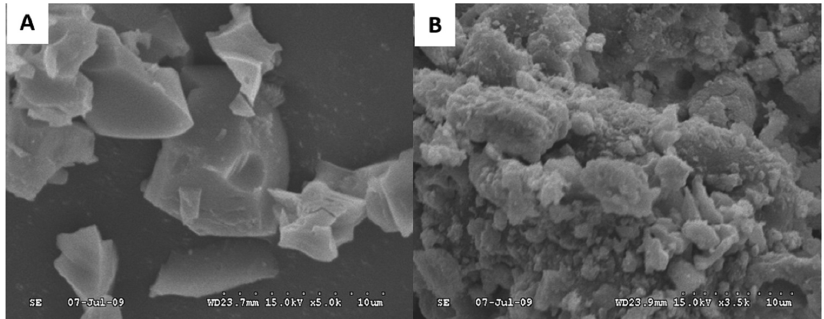
Figure 14. Adapted with permission from W. C. Liu et al. [81]. Copyright 2019 Elsevier. License number 5318870269625. SEM images of ( A ) C 3 S and ( B ) Hap/C 3 S (C-50) particles. number 5318870269625. SEM images of ( A ) C 3 S and ( B ) Hap/C 3 S (C-50)